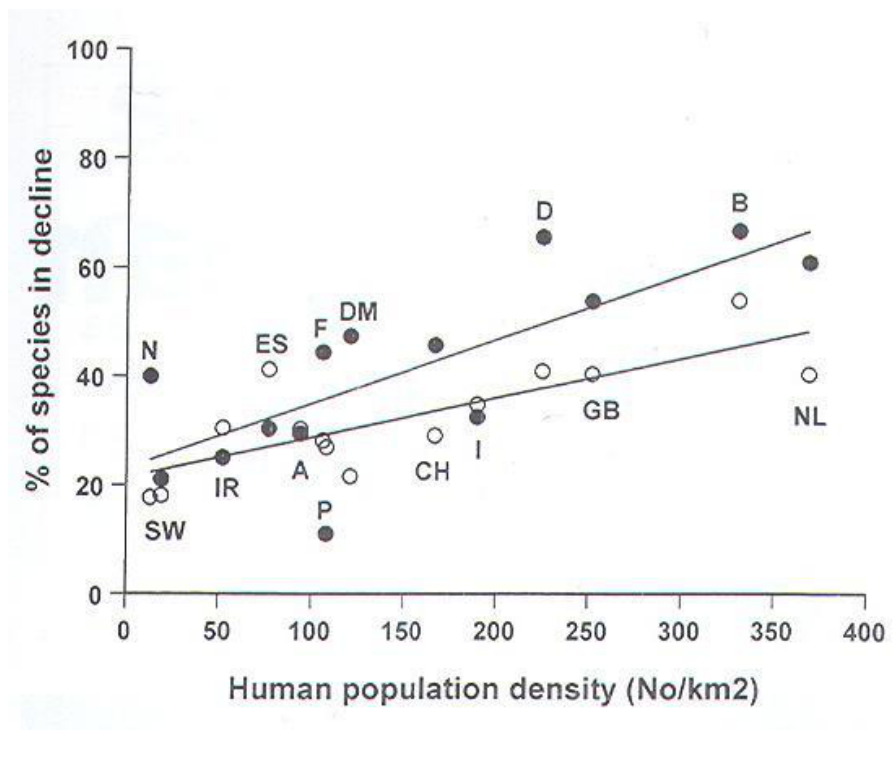
Figure 2. Human population density and wildlife declines. ● , herpetofauna (amphibians and ○ reptiles combined); , birds. A, Austria; B, Belgium; CH, Switzerland; D, Germany; DM, Denmark; ES, Spain; F, France; GB, Britain; I, Italy; IR, Ireland; N, Norway; NL, Netherlands; P, Portugal; SW, Sweden. Reproduced with permission from